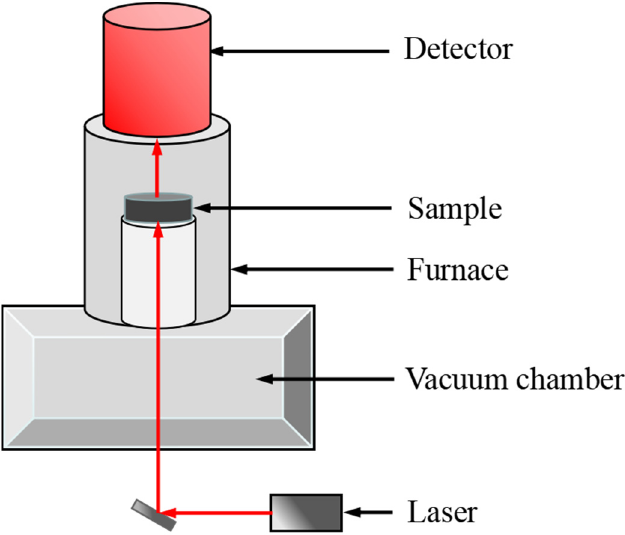
Figure 4. Schematic of LFA device for thermal diffusivity measurement.